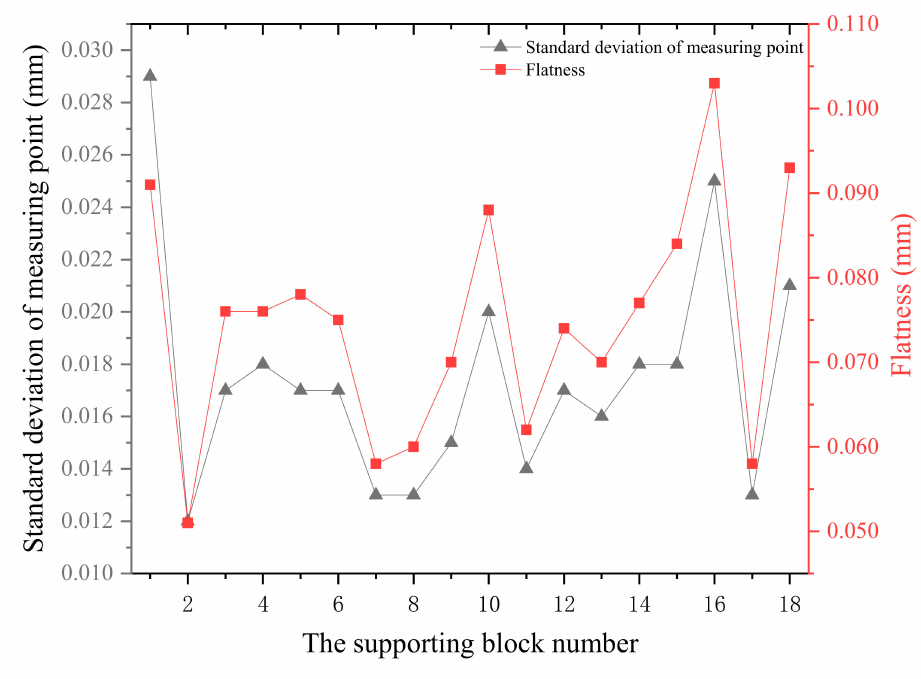
Figure 17. Statistical results of standard deviation of the measuring points and the flatness.